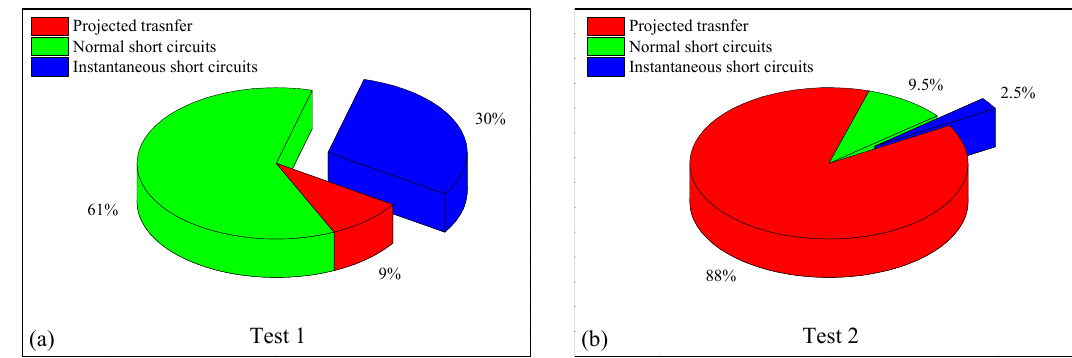
Figure 7. The percentages of various types of droplet transfer in the partial projected transfer zone: ( a ) Test 1; ( b ) Test 2.